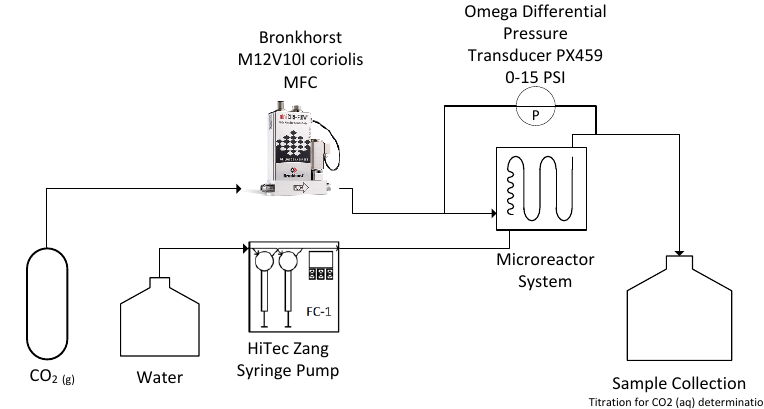
Water Water Sample Collection Titration for CO2 (aq) determination Figure 1. Set-up of flow visualization, pressure drop, and interphase mass transfer experiments.